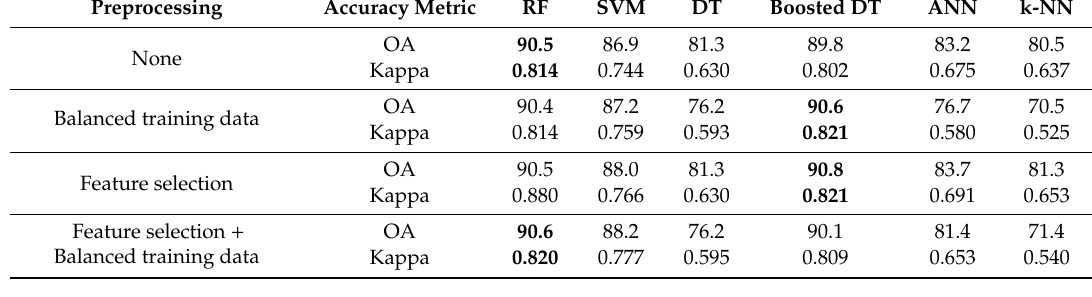
Table 8. OA (%) and Kappa statistic results for each tested classifier and preprocessing scenario. Bold denotes the best accuracies for each preprocessing scenario. The 75% of the labeled samples were used for training and the remaining ones for validation.